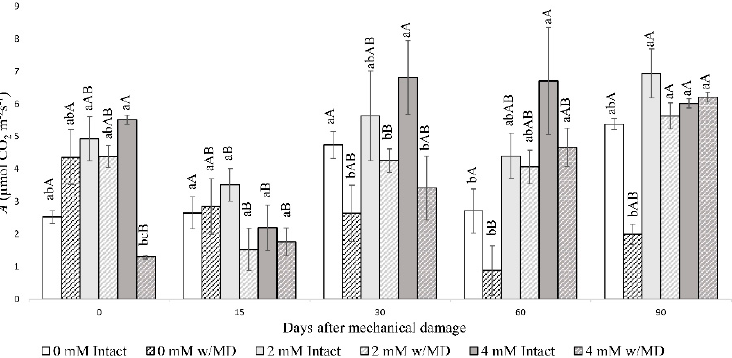
Figure 3. CO 2 assimilation rate ( A , µ mol CO 2 m − 2 s − 1 ) p < 0.001 in Annona emarginata plants submitted to the treatments: 0 mM Ca 2+ without mechanical damage (intact), 0 mM Ca 2+ with mechanical damage (w/MD), 2 mM Ca 2+ intact; 2 mM Ca 2+ w/MD, 4 mM Ca 2+ intact, and 4 mM Ca 2+ w/MD, at evaluation times: 0 (30 min) 15, 30, 60, and 90 days. Values correspond to means ± SE ( n = 4). Lowercase letters indicate differences between treatments within each evaluation time and uppercase indicate differences between each treatment over evaluation time. Lowercase letters indicate the differences between the treatment and capital letters between evaluation